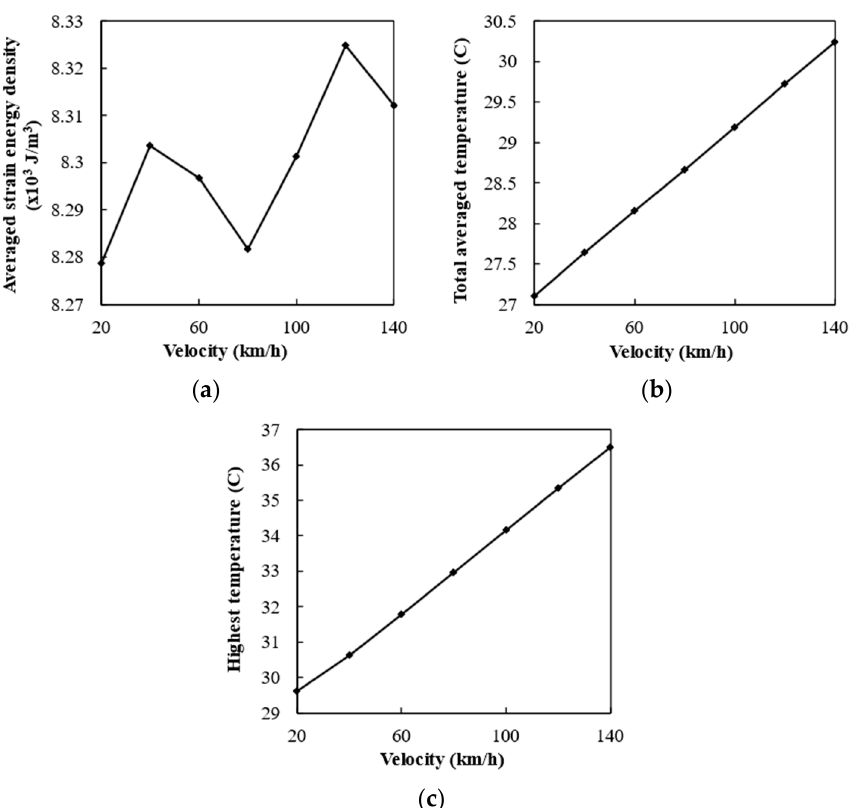
Figure 16. Variation in the three variables with varying velocity: ( a ) strain energy density; ( b ) aver- aged temperature; ( c ) highest temperature.